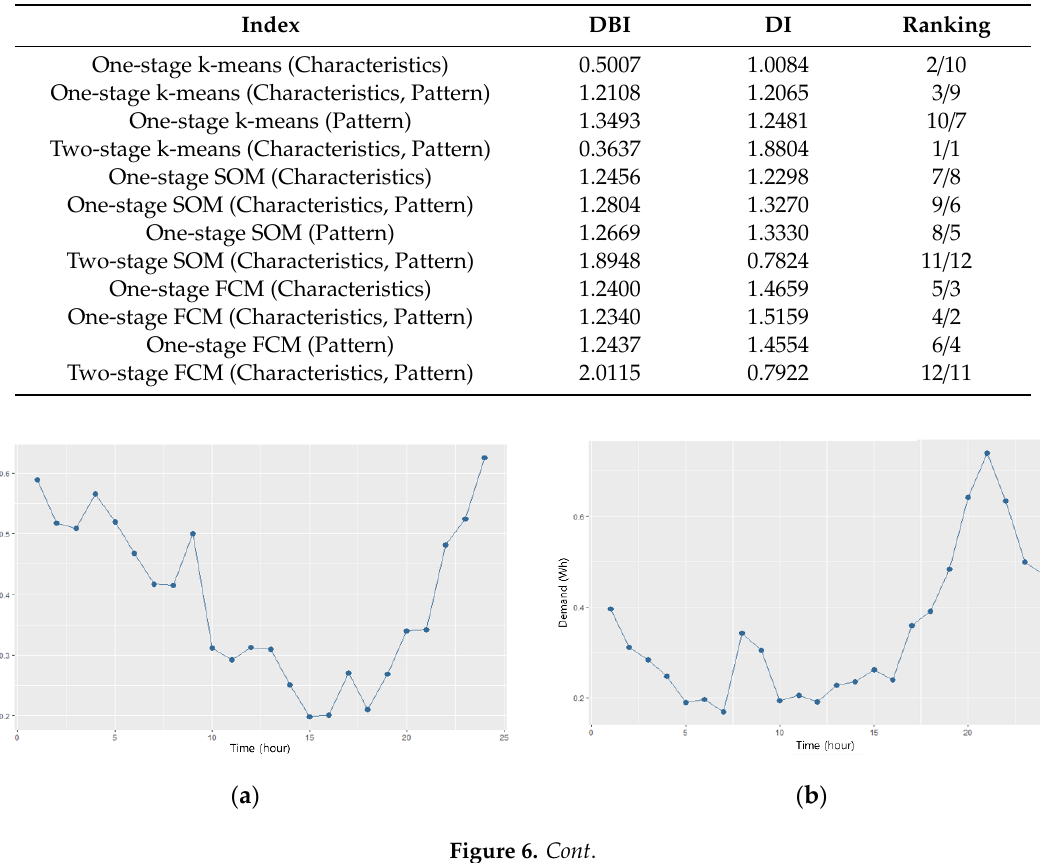
Table 3. DR operation clustering result evaluation according to variable selection and clustering structure.